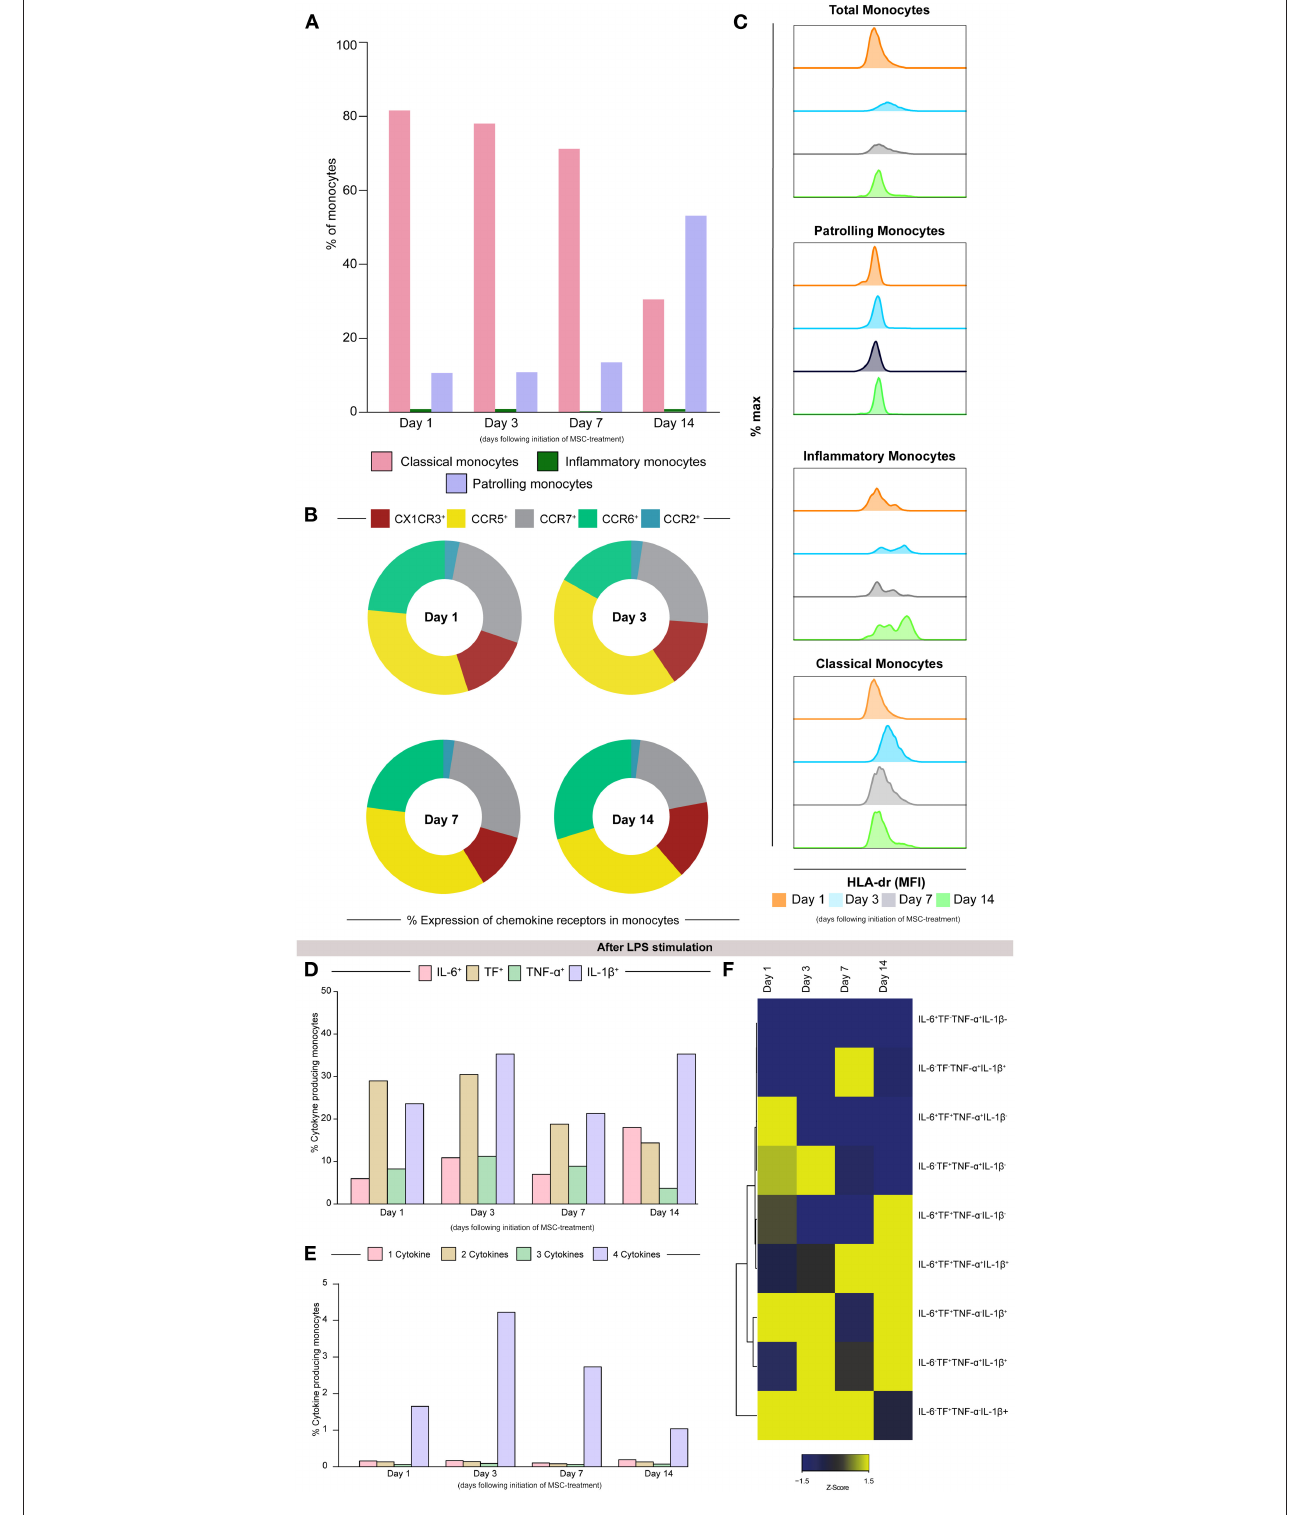
FIGURE 3 | The classical monocytes (CD14 ++ CD16 − ) are more prevalent up to 7 days after treatment initiation. (A) The frequency of classical (CD14 ++ CD16 − ), inflammatory (CD14 ++ CD16 + ), and patrolling (CD14 + CD16 + ) monocytes (pink, green, and purple, respectively), exhibits the same overall profile until day 7. On